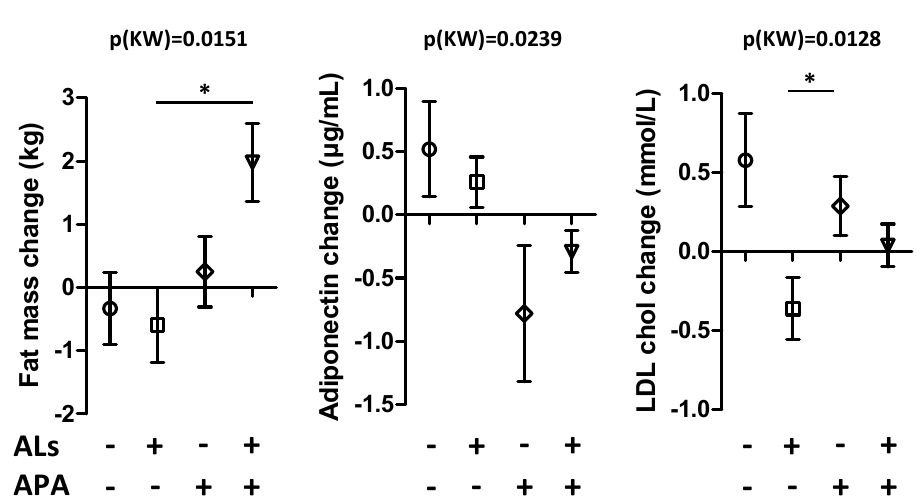
Figure 3. Changes after the 3-month wash-out period. Changes in fat mass, plasma adiponectin, LDL cholesterol observed after 3 months of the wash-out period following 6 months of treatment in the 4 groups of patients receiving (or not) arginine and leucine supplementation (ALs) and following (or not) the adapted physical activity program (APA). Data were compared using the Kruskal– Wallis test (KW) followed by Dunn post tests. * p < 0.05.